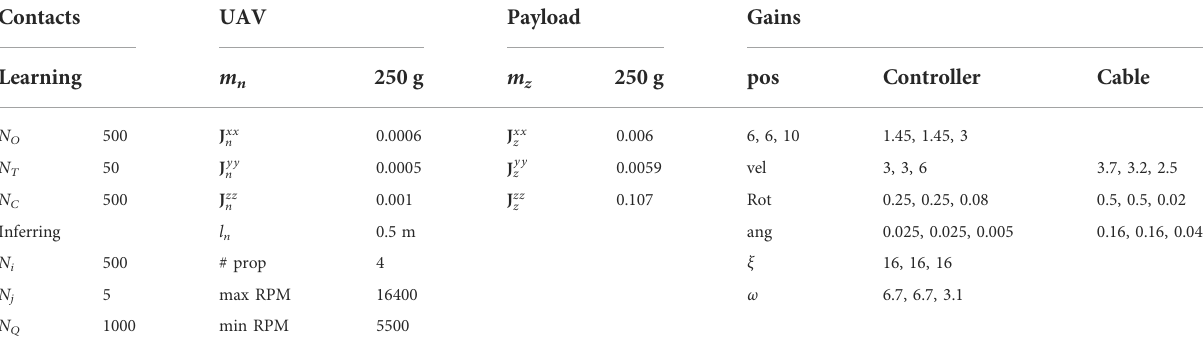
TABLE 1 Experimental parameters. All of the parameters are kept constant over the experiments. We use diagonal inertia matrices for both the UAVs and payloads. The gains values are for the x − , y − and z − components, respectively. UAV and gains parameters are taken from (Li et al., 2021b).